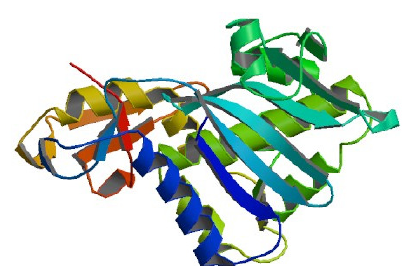
Figure 2. Crystal structure of Saporin-L1 (https://doi.org/10.2210/pdb3HIS/pdb) (Source: RCSB PDB)